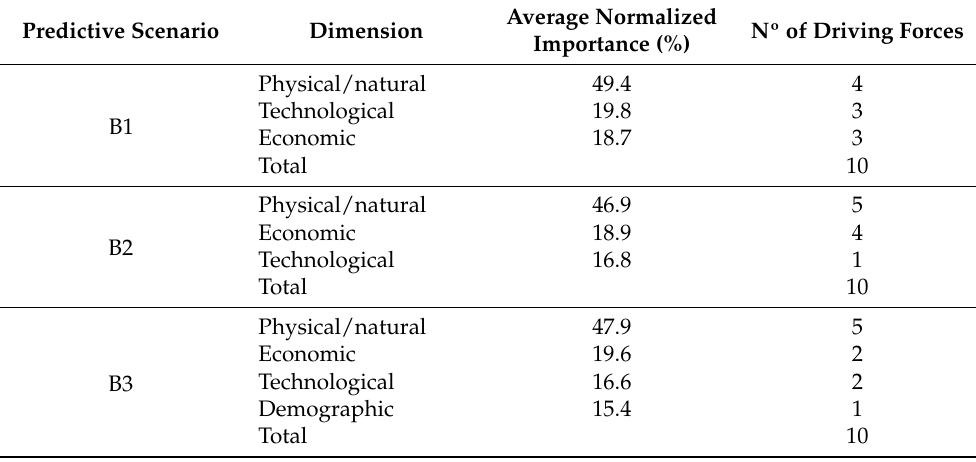
Table 13. Statistics per analysis dimension of normalized importance of the ten first driving forces in LULC dynamics for the predictive scenarios